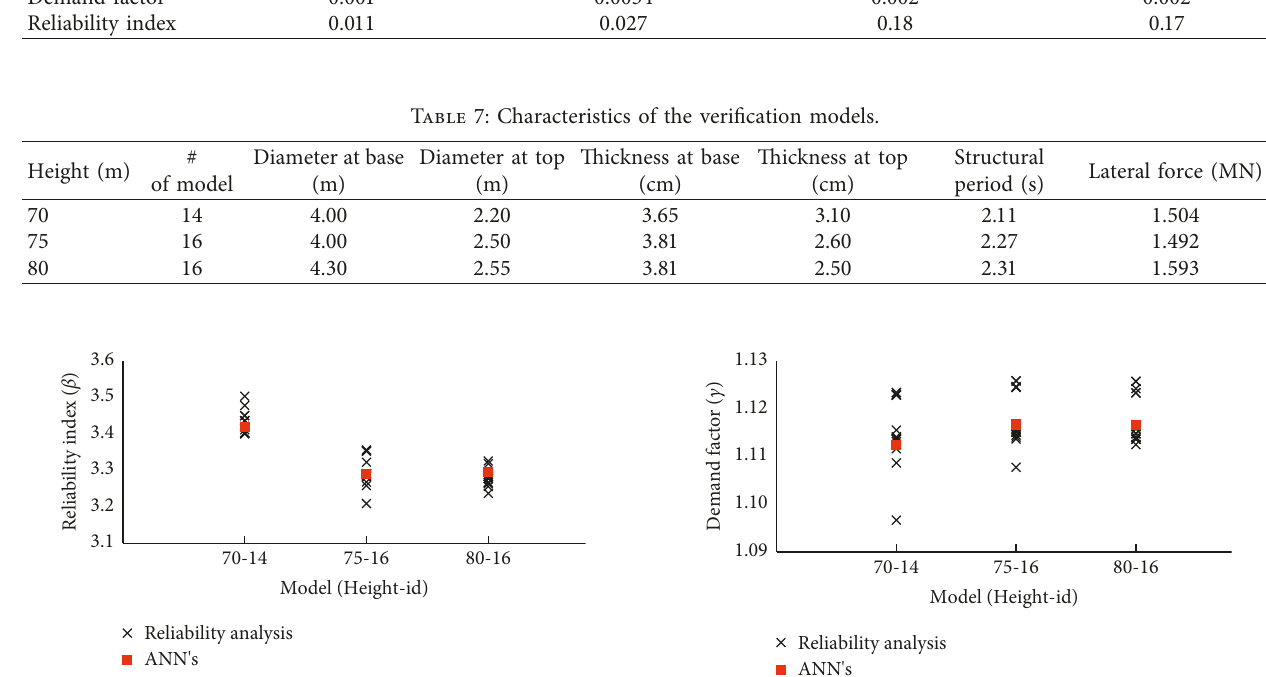
Figure 8: Structural reliability index corresponding to the verifi- cation models.